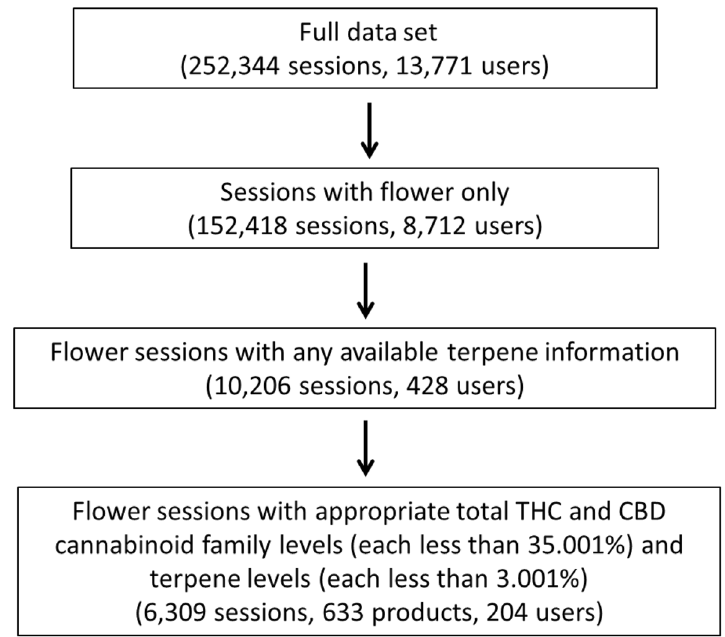
Fig. 1 Diagram of flowchart of inclusionary criteria for data